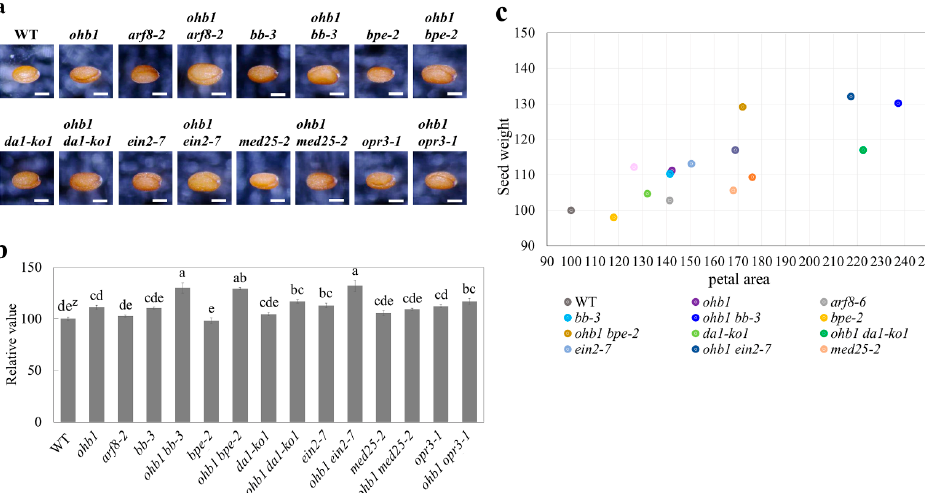
Figure 5. Phenotypic characteristics of the seeds produced by the single and double mutants derived from ohb1 and previously known large flower mutants. ( a ) Seeds from the WT and each large flower mutant. Bars represent 250 μ m. ( b ) Comparison of the seed weights among the 15 lines except for ohb1 arf8-2 . Each value is expressed as the mean ± SE relative to the WT value, which was set at 100. z Different letters represent significant differences between mutants according to Tukey’s test (n = 5, p < 0.05). ( c ) Scatter plot of petal area versus seed wight.